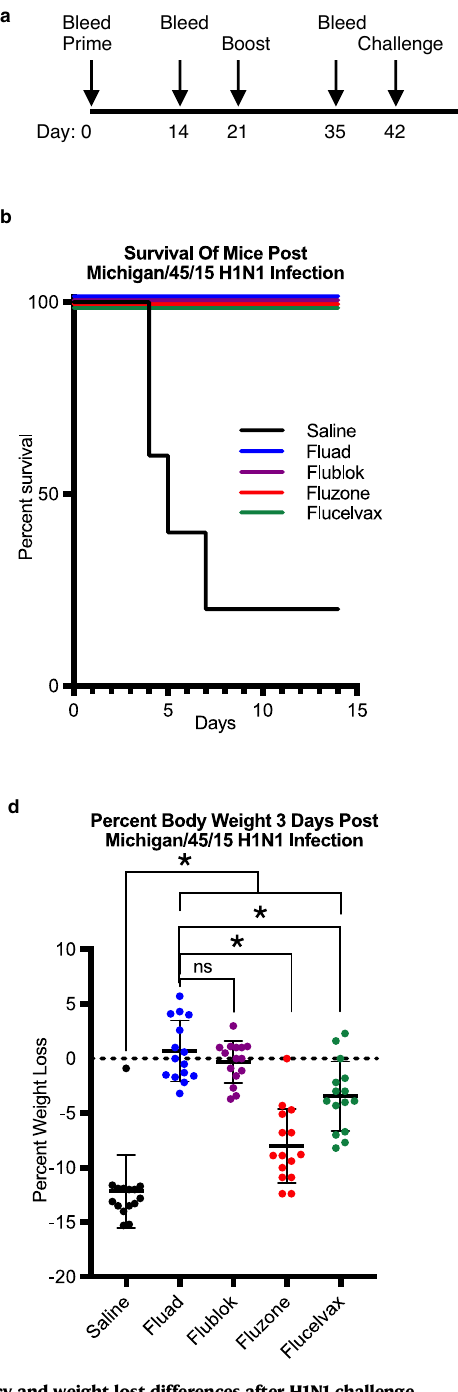
multiple comparisons test with two-tailed signi fi cance found no statistical differ- ence in weight-loss between Flublok and Fluad as denoted (i.e., ns.). Asterisks denote statistical differences ( p <0.05) in weight-loss between saline control as compared to vaccines (Flublok, Fluad, Fluzone HD, Flucelvax) and statistical dif- ferences between Flublok and Fluad versus the other vaccines, Fluzone HD and Flucelvax. e Mouse lung titers were determined by 50% Tissue Culture infectious Dose (TCID50) for tissues taken day three post-H1N1 challenge and compared between commercial in fl uenza vaccines. Graphs display mean with standard error of the mean